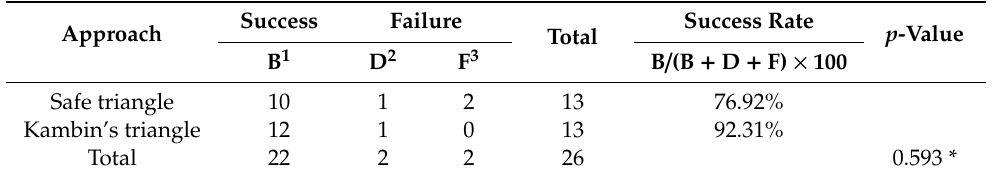
Comparison of the success rate of the procedure between the safe-triangle and Kambin’s-triangle